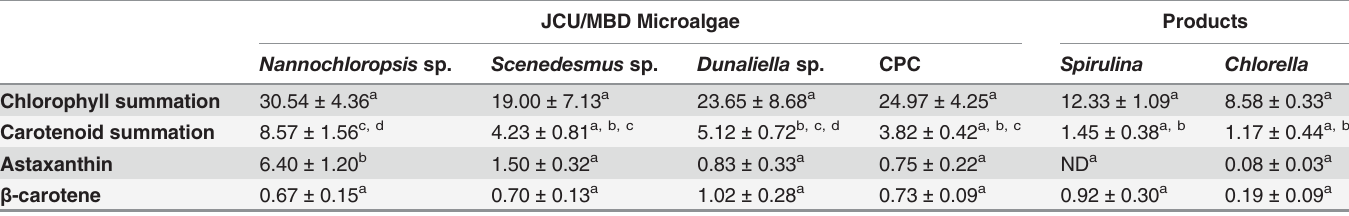
Table 3. Mean pigment content (mg g -1 dry weight) of James Cook University/MBD Energy (JCU/MBD) microalgae and commercial microalgae products (mean ± SD, n = 3). JCU/MBD Microalgae